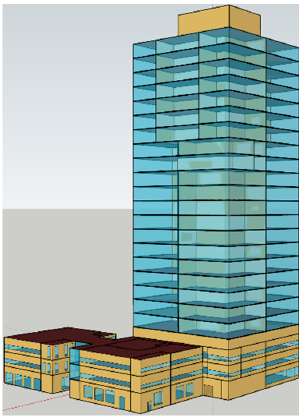
Figure 2. The physical model of the building in Google Sketchup.